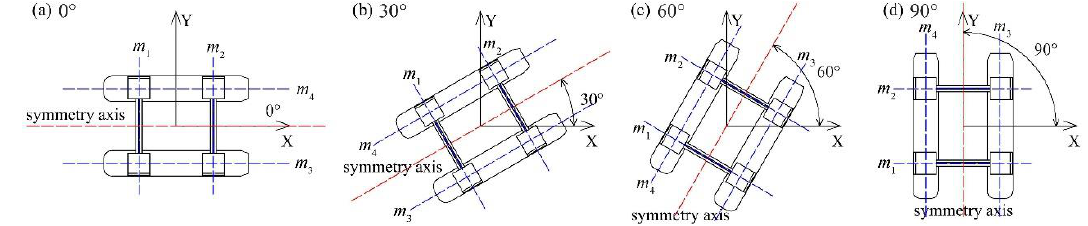
Figure 12. Schematic illustration of ISW propagation over the extended cylinder.